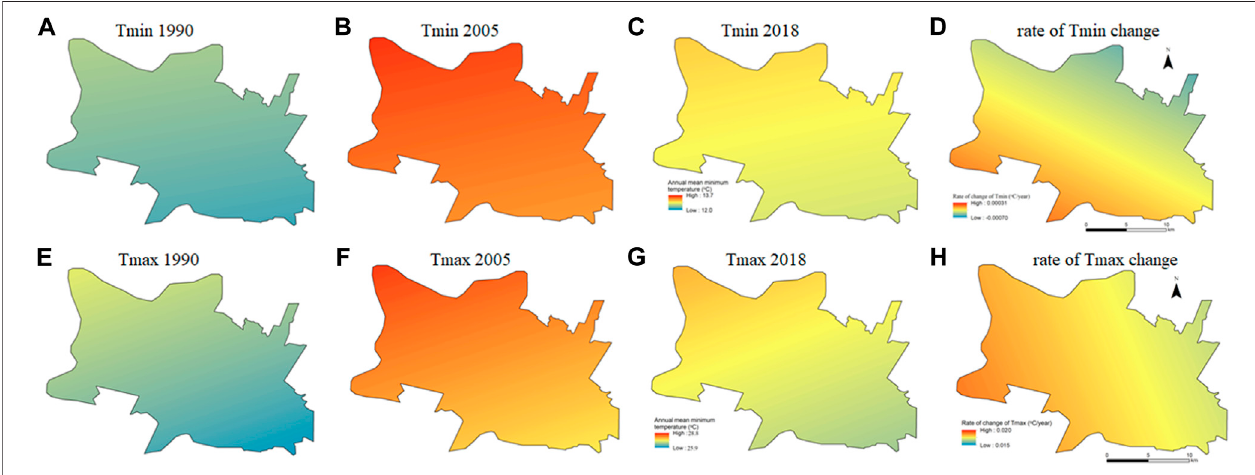
FIGURE2| Annualmeanminimumtemperatures (A – C) andtheirrateofchange (D) aswellasannualmeanmaximumtemperatures (E – G) andtheirrateofchange (H) from 1990 to 2018.